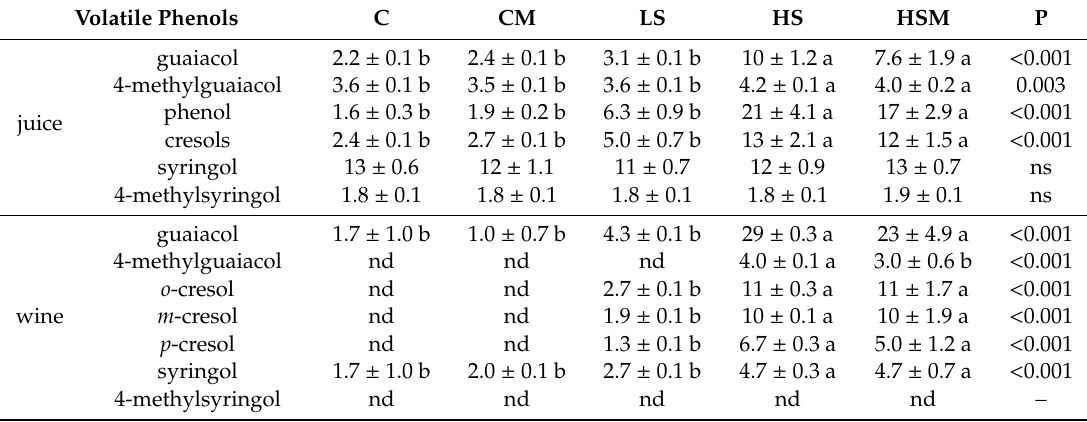
Table 2. Concentrations of volatile phenols in juice ( µ g / L) from control and smoke-exposed grapes at maturity (t = 4), and in corresponding wines ( µ g / L), with and without in-canopy misting; di ff erent densities of smoke were achieved by burning di ff erent amounts of